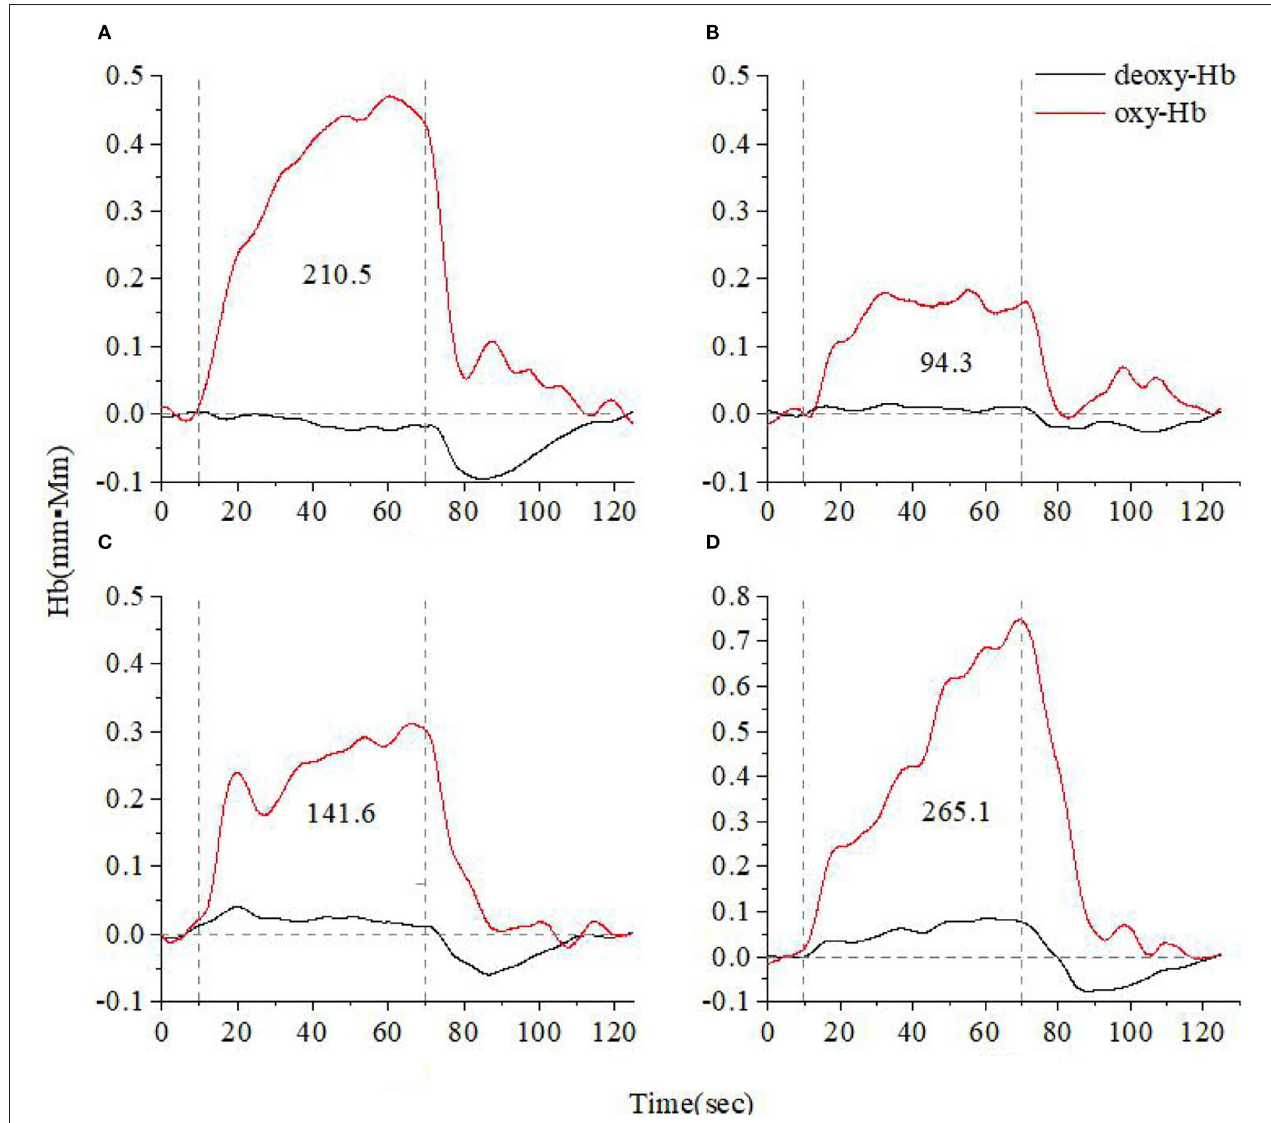
FIGURE 4 | Time course of the average hemoglobin concentration of 10 people under verbal fluency task (A) . Time course of the average hemoglobin concentration of 10 anxiety and depression patients at the acute (B) , consolidation (C) , and maintenance stages (D) . All of them completed the high-level cognition task. The red line indicates the amount of change in oxyhemoglobin concentration (oxy-Hb), and the black line indicates the amount of change in deoxyhemoglobin concentration (deoxy-Hb). The numbers indicate integral